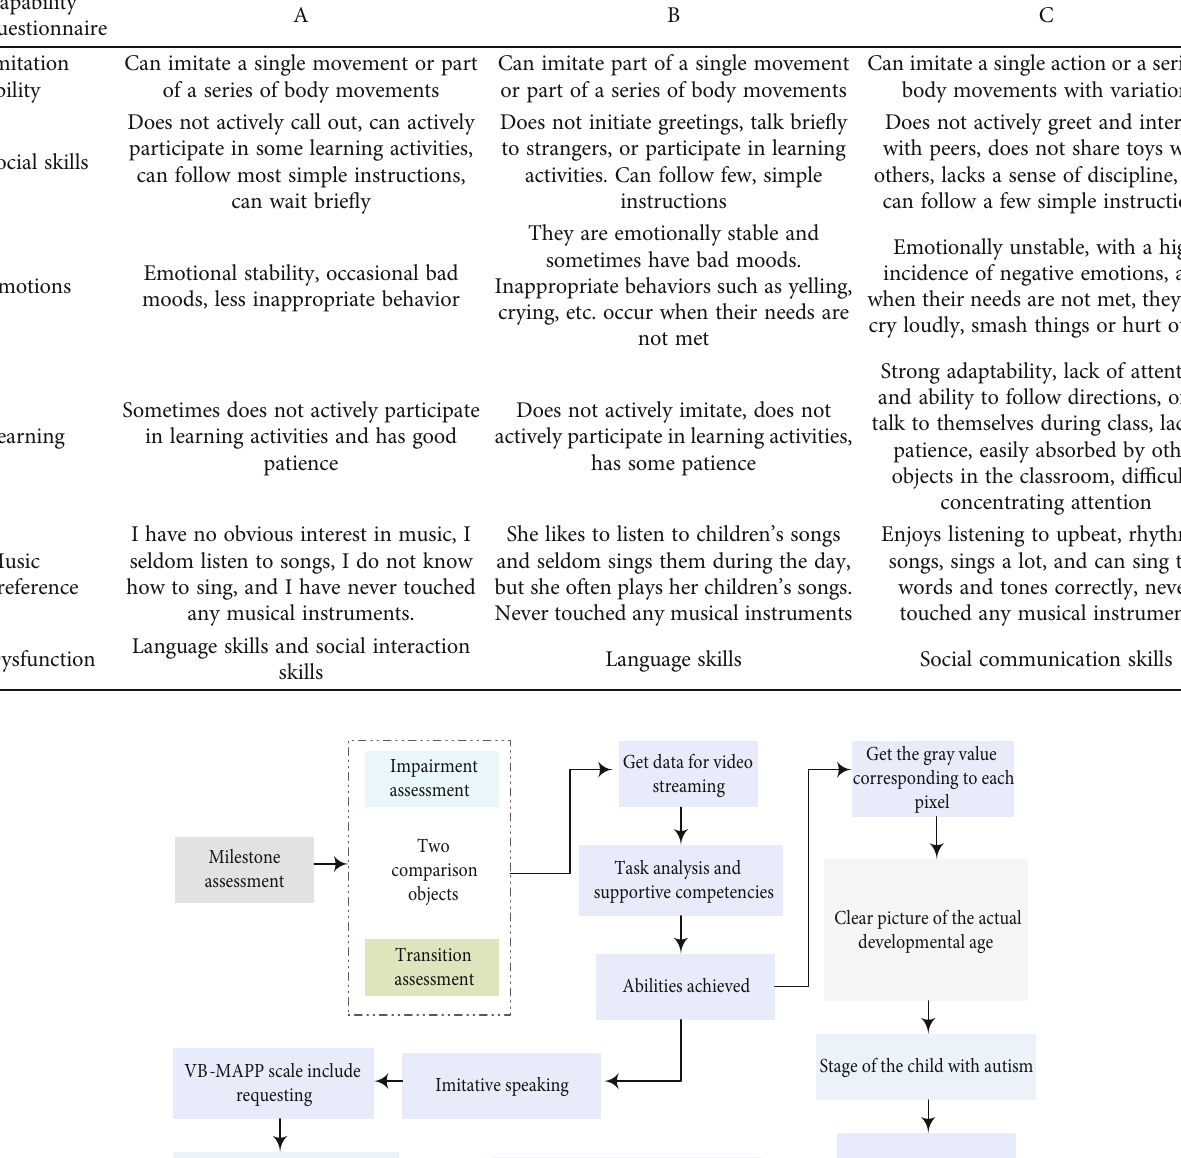
Table 2: Questionnaire on various abilities of children with autism.